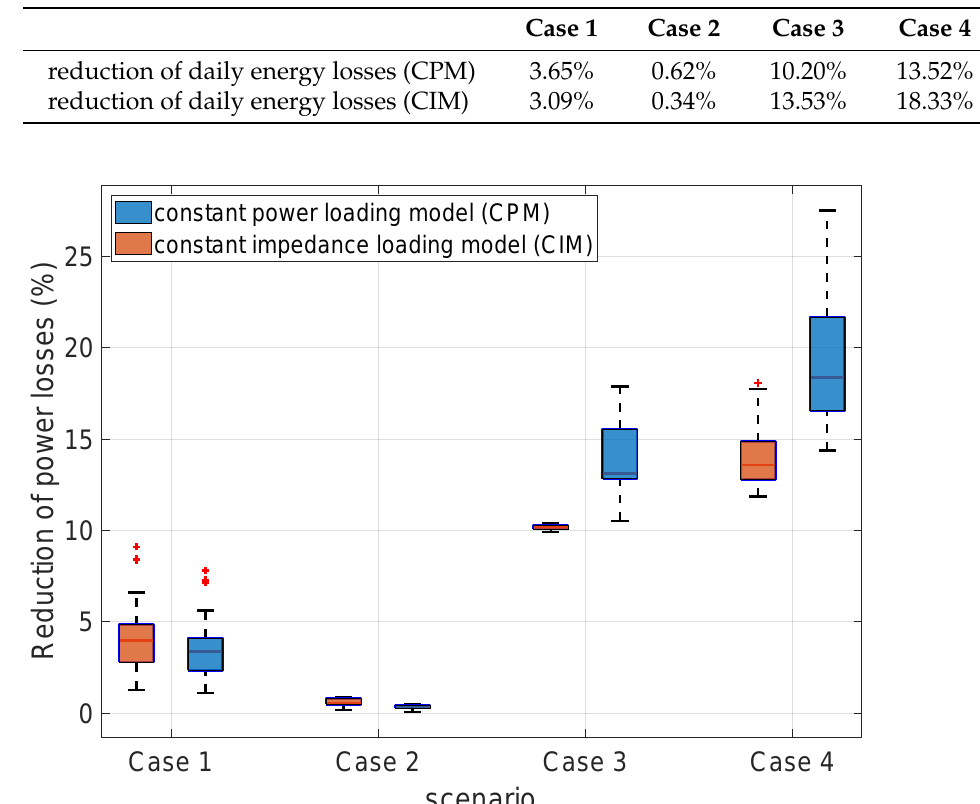
Table 2. Reduction in daily energy losses for different loading models.